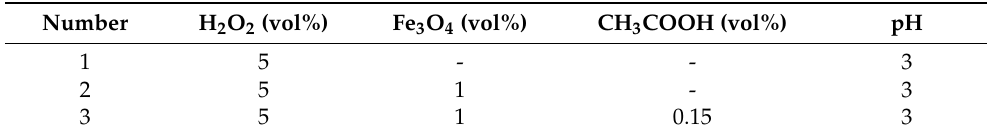
Table 2. Components of different